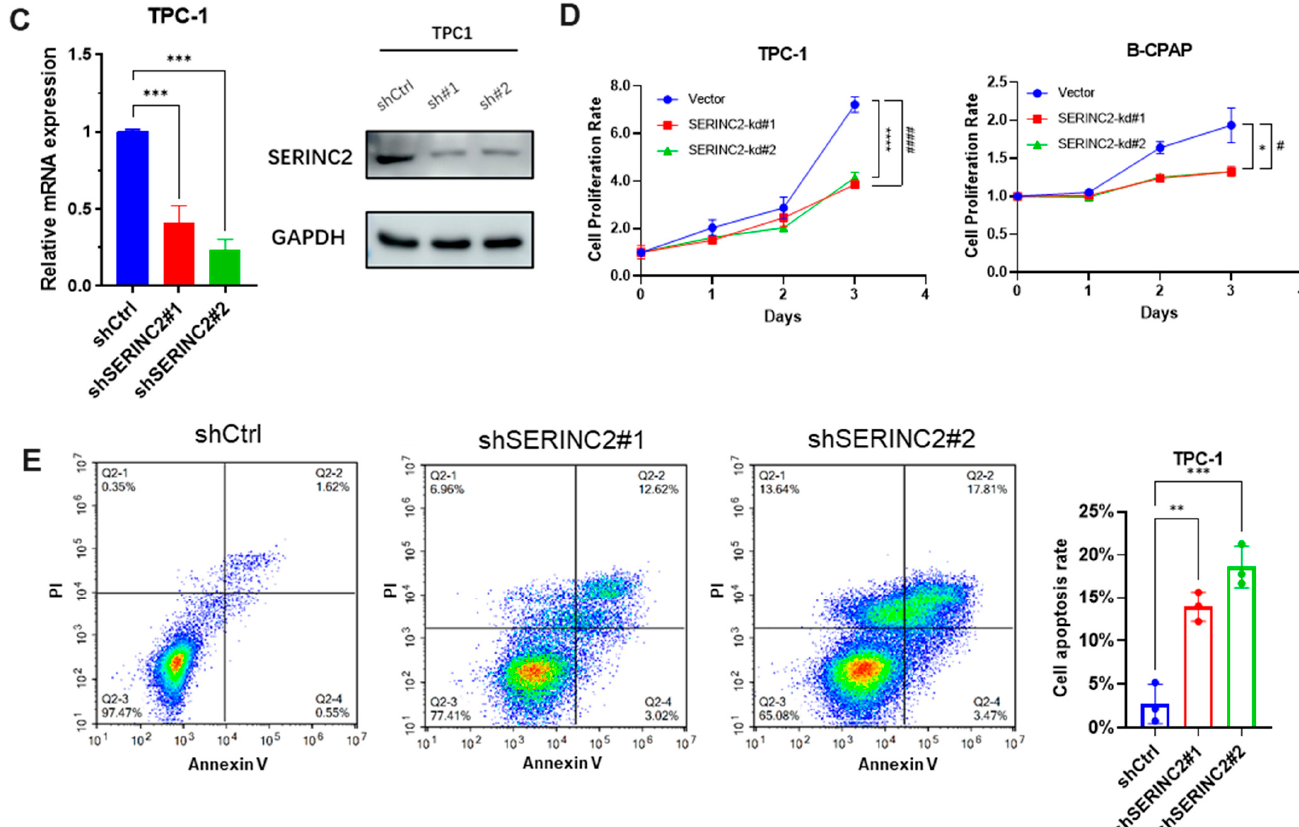
Figure 5. Regulation of SERINC2 influences papillary thyroid cancer progression . A. Relative mRNA expression levels of SERINC2 in TPC-1 were significantly up-regulated by transfecting pcDNA3.1 plasmids for 48 h. B. TPC-1 cells were transfected with pcDNA3.1 plasmids, followed by measurements of cell growth by CCK-8. C. mRNA levels of SERINC2 were knocked down with shRNA in TPC-1 cells. D. Knockdown of SERINC2 with shRNA plasmids disrupted the cell proliferation in TPC-1 cells. E. Apoptotic levels in TPC-1 cells transfected with shRNA were determined by a flow cytometer. Results are presented as the mean ± SEM. *, # p < 0.05, ** p < 0.01, *** p < 0.005 and ****, #### p < 0.001.